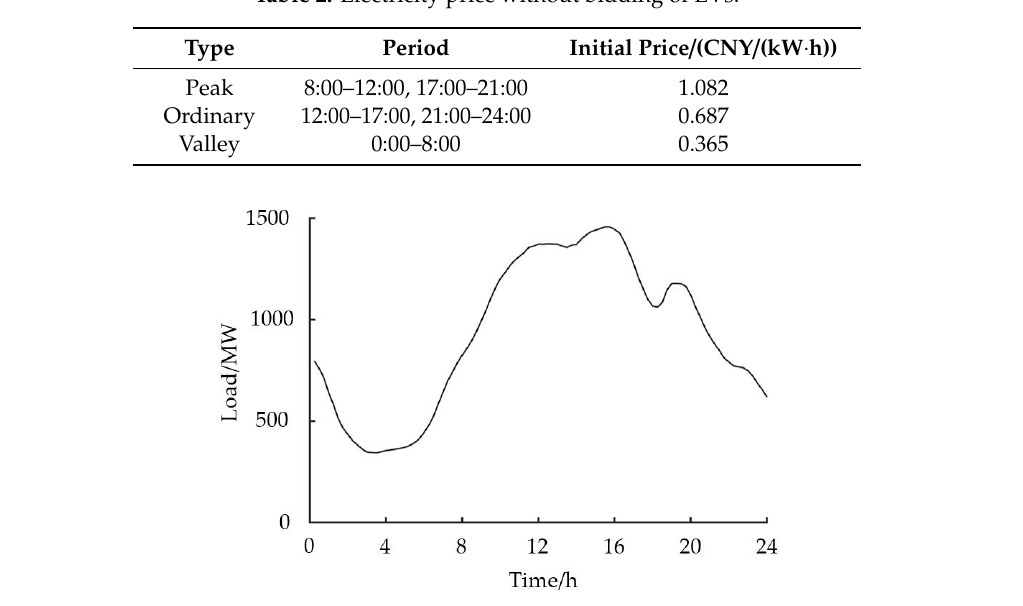
Table 3. Optimization range of charging electricity price.